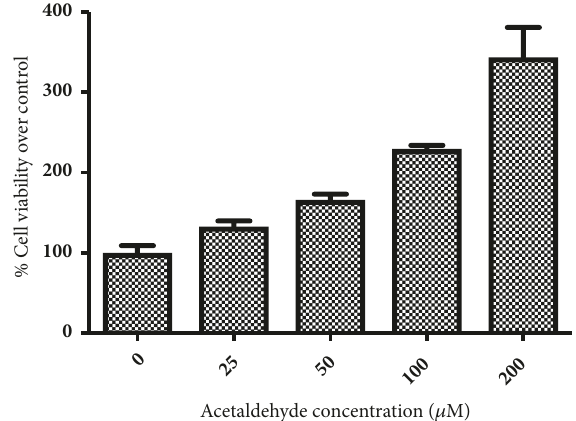
Figure 2: Percentage of viable cells after 24-hour treatment of LX-2 cells with acetaldehyde at 0, 25, 50, 100, and 200 𝜇